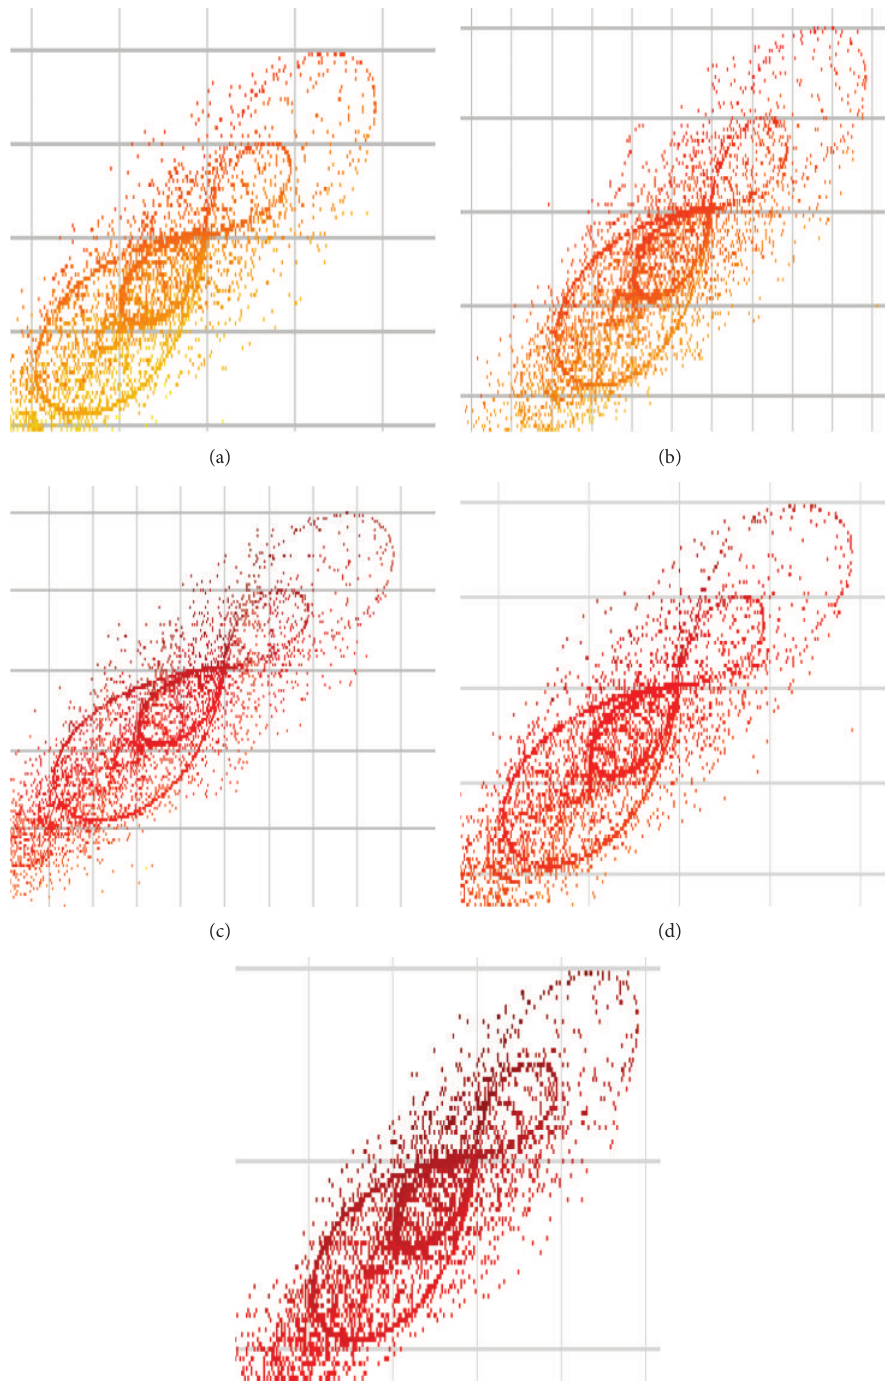
Figure 7: (a) Heating rate of 10K/min, 𝑅 = 0.8 , (b) heating rate of 10K/min, 𝑅 = 1.1 , (c) heating rate of 10K/min, 𝑅 = 1.4 , (d) heating rate of 10K/min, 𝑅 = 1.7 , and (e) heating rate of 10 K/min, 𝑅 = 2.0 . (The horizontal axis and vertical axis are, respectively, 𝑥(𝑡) -DTG and 𝑥(𝑡 + 1) -DTG, the colour indicated the